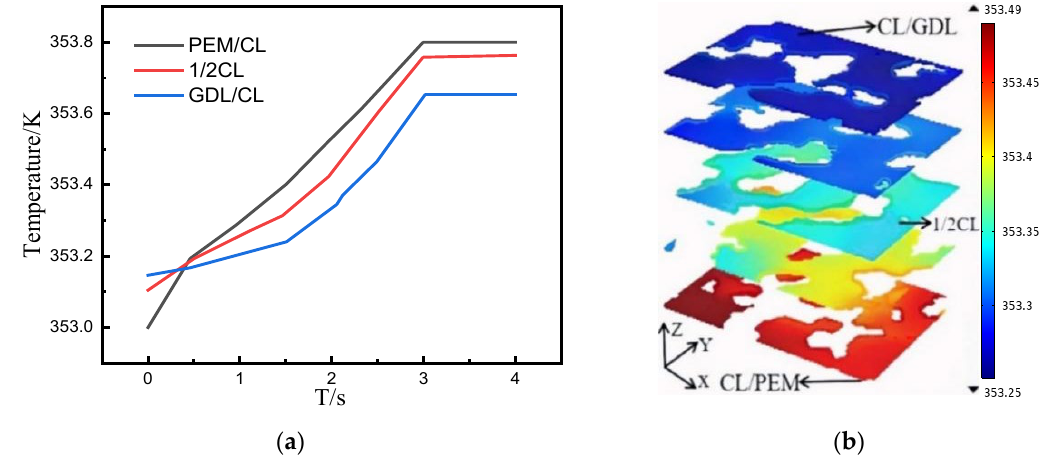
Figure 7. ( a ) Profiles of temperature at CL/GDL interface, CL/PEM interface, and CL middle section at different moments. ( b ) Temperature distribution of different sections along the CL thickness di- rection when the reaction is